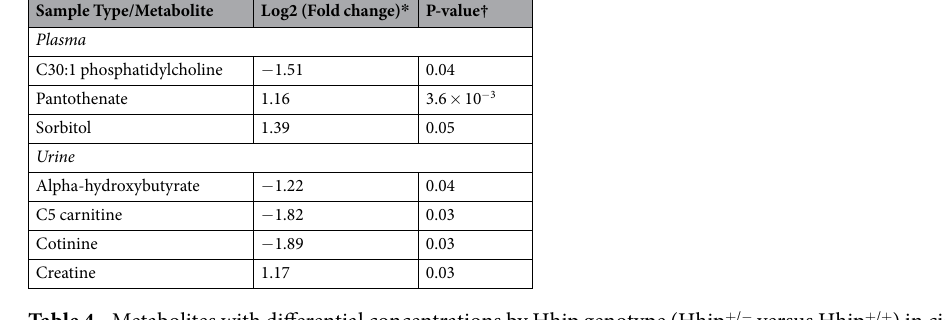
Table 4. Metabolites with differential concentrations by Hhip genotype (Hhip + / − versus Hhip + / + ) in cigarette smoke-exposed mice. * Negative values indicate lower concentration in Hhip + / − heterozygotes (minimum 2x fold change). †Student’s t-test. No metabolites met the thresholds for significance in lung